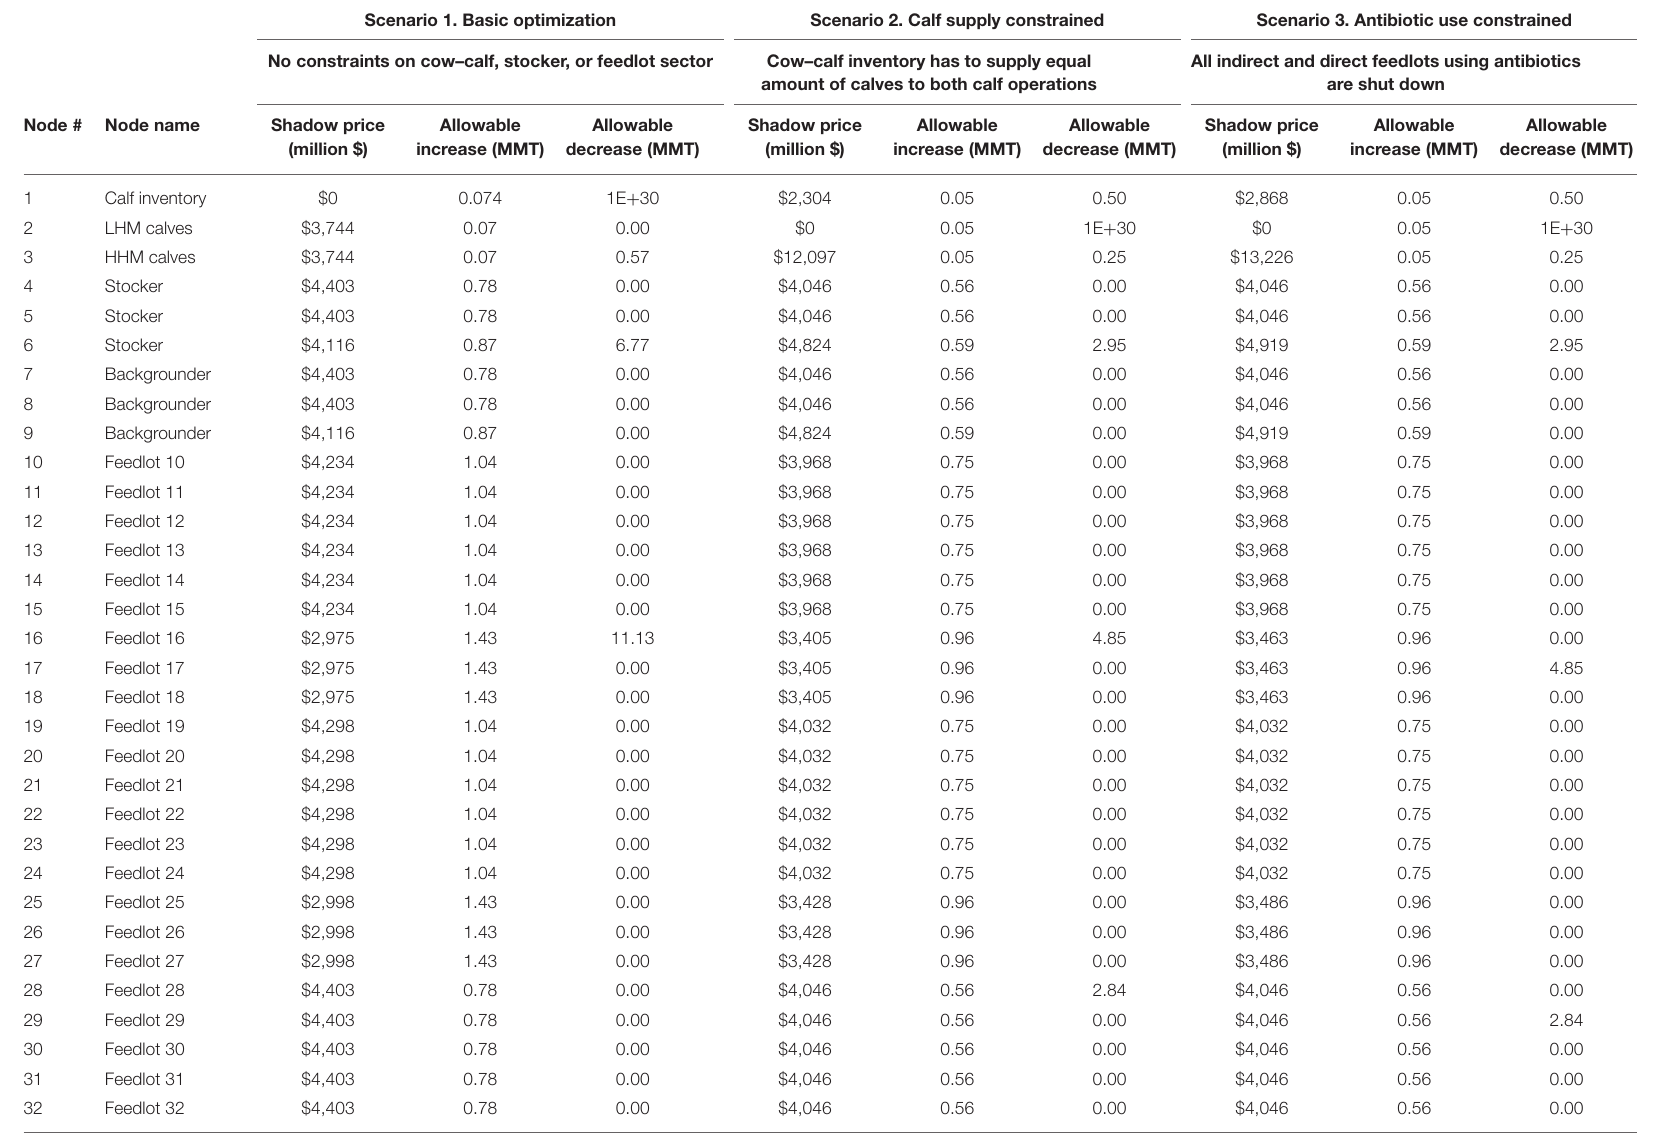
TABLE 2 | The increase in the total cost to the integrated beef supply chain network model when the beef retention in each of the 37 node constraints is incremented by 1 million metric ton (MMT; shadow price), and the allowable range of beef retention (in MMT) for the node is shown for each of the three different linear programming